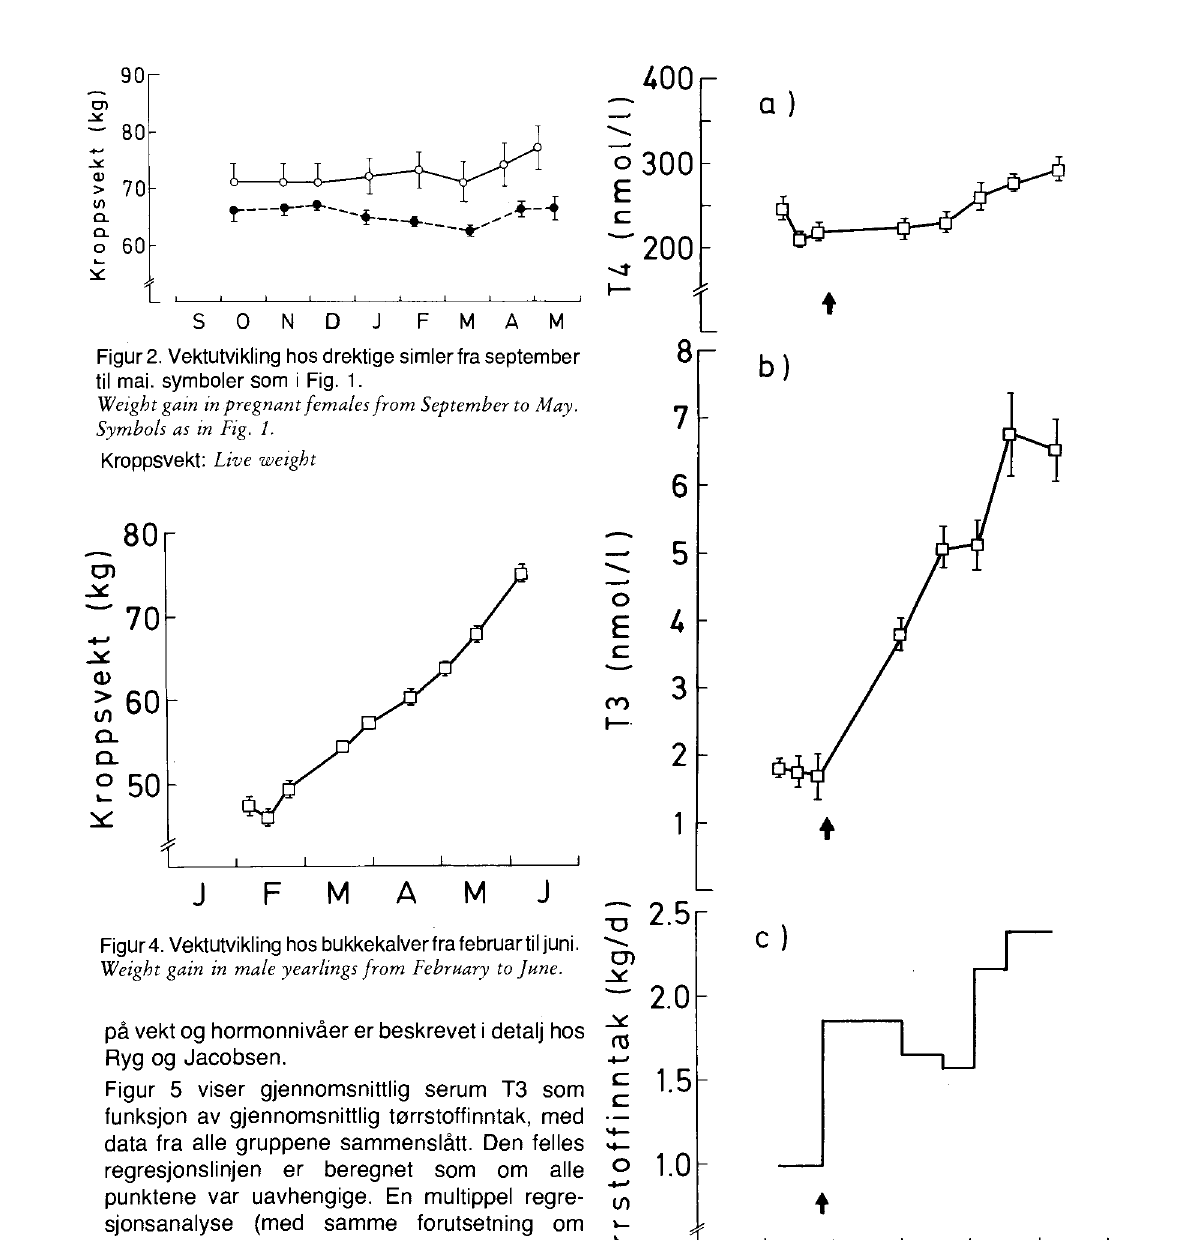
Figur 4. Vektutvikling hos bukkekalver fra februar til juni. Weight gain in male yearlings from February to June. på vekt og hormonnivåer er beskrevet i detalj hos Ryg og Jacobsen. Figur 5 viser gjennomsnittlig serum T3 som